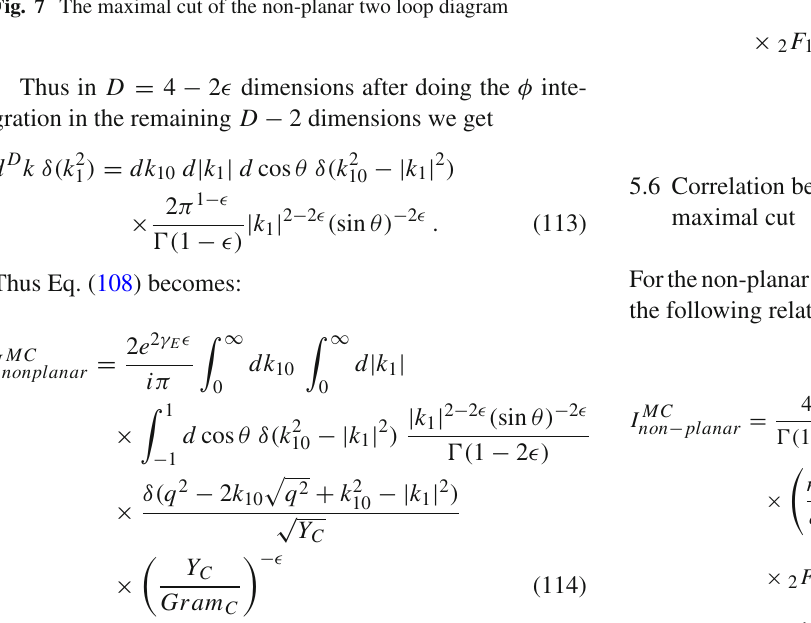
Fig. 7 The maximal cut of the non-planar two loop diagram